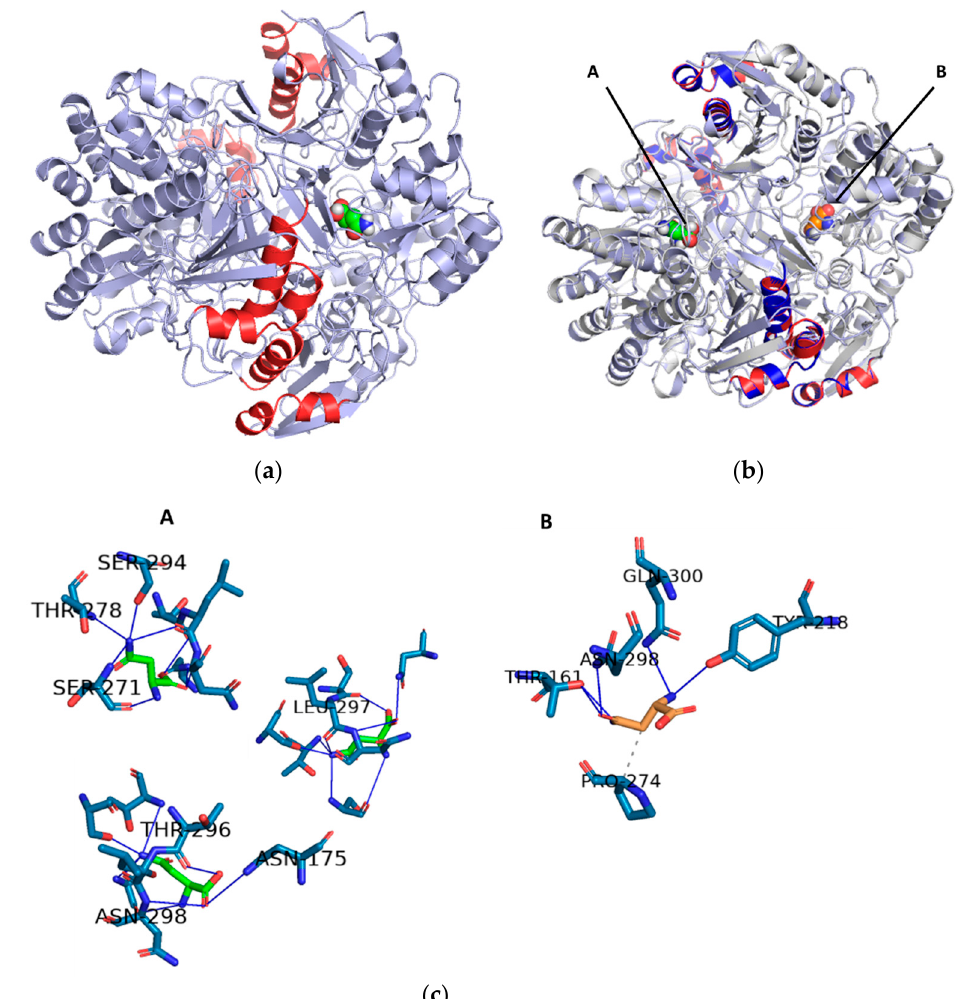
Figure 5. Docking of chimeric humanized L-asparaginase derived from 3ECA with fragments of human L-asparaginase 4O0H with the substrate asparagine. ( a ) The chimeric enzyme is shown in tetrameric conformation with four independently folded subunits. Towards the interior, the asparagine substrate is spherical and is interacting with the enzyme residues ( b ) Alignment of the docking of humanized chimeric L-asparaginase derived from 3ECA with fragments of human L-asparaginase 4O0H with the substrate asparagine and of the docking of the native E. coli 3ECA protein with the substrate asparagine. The chimeric enzyme is shown in tetrameric conformation with four independently folded subunits aligned with the L-asparaginase enzyme. Towards the interior, the substrate asparagine has a spherical shape and is interacting with the enzyme residues. (A) corresponds to the interaction with the chimera enzyme and (B) to the interaction with the native E. coli template enzyme. There is a 100% structural match with no doublets or chain breaks. Both substrates are arranged in di ff erent subunits of the protein. ( c ) Interaction of residues of the active center of chimeric humanized L-asparaginase derived from 3ECA with fragments of human L-asparaginase 4O0H and of the native E. coli 3ECA protein with the substrate asparagine. (A) The interaction of the amino acids of the active center of the chimeric enzyme with asparagine is shown. The hydrogen bridge bonds established between the substrate and the amino acids of the active center can be seen in blue. (B) The interaction of the amino acids of the active center of the native E. coli enzyme with asparagine is shown. The hydrogen-bridging bonds between the substrate and the amino acids of the active center can be seen in blue and the hydrophobic interactions are represented by a dashed line.